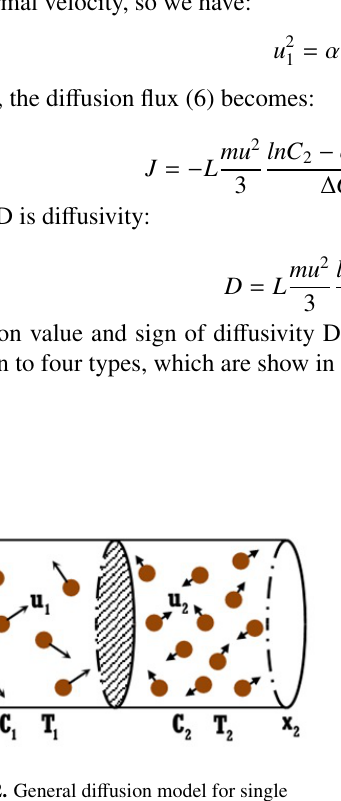
Figure 2. General di ff usion model for single component.